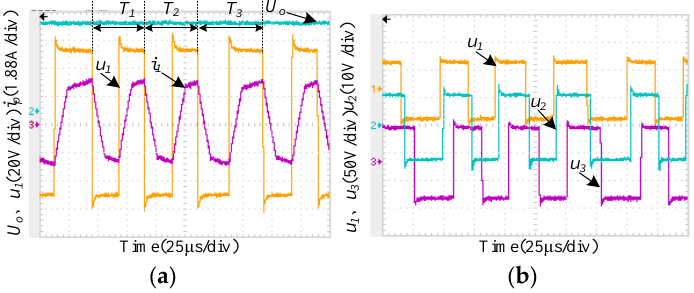
Figure 22. Measured waveforms of shifted-phase angle control using continuously chaotic modulation: ( a ) converter voltage, current of port 1 and output voltage of port 2; ( b ) converter voltages of port 1, 2 and 3.